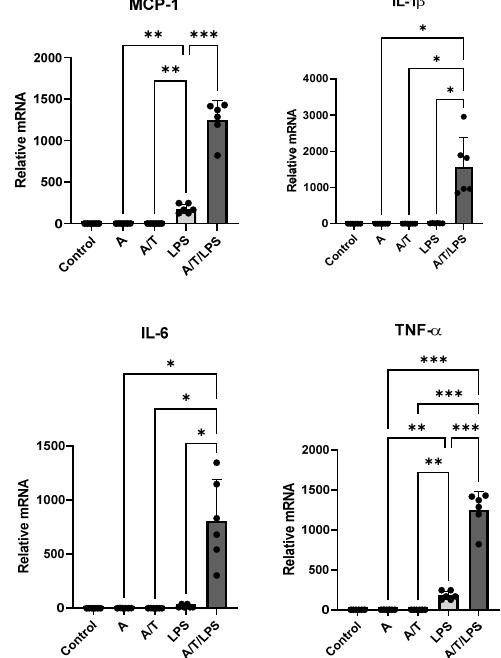
Figure 5. Gene expression of inflammatory cytokines (MCP-1, IL-1 β , IL-6, and TNF- α ) in human adipocytes in the presence of LPS alone and in combination with T (A/T/LPS). Control cultures were incubated in the presence of vehicle only. A complete set of six experiments for each treatment was performed from each subject and run in triplicate. Data are expressed as mean ± DS. Each black dot represents the mean of triplicate measurements of a single experiment.* p < 0.05; ** p < 0.001; *** p < 0.005.